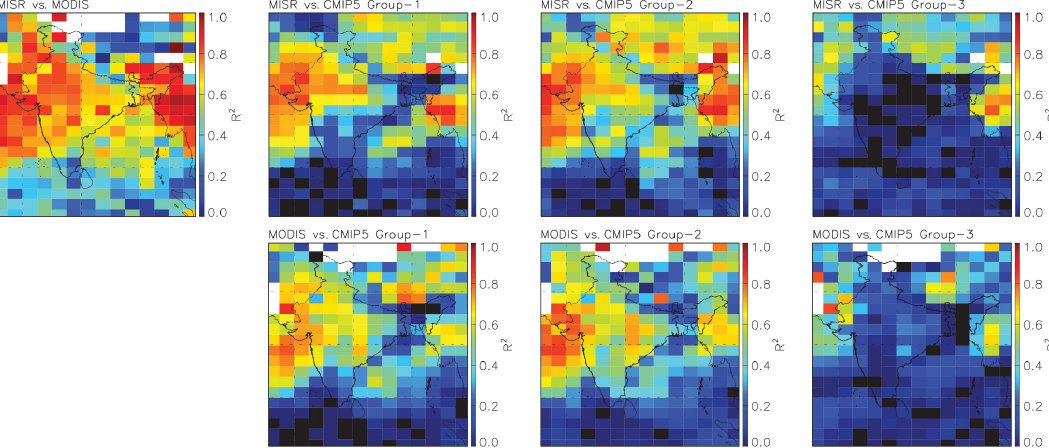
Figure 2. Spatial correlation map (2000–2005) for three model groups defined in the text with MISR and MODIS. The map of correlation between MISR and MODIS derived AODs is also